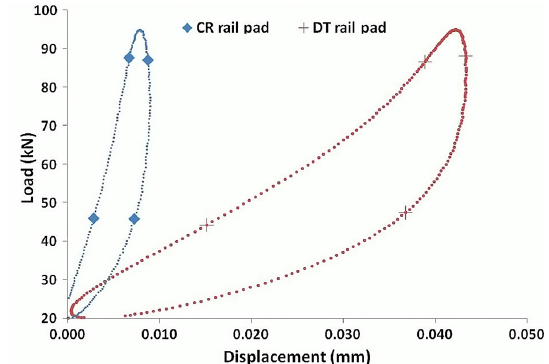
Fig. 5. Load-displacement curve of the dynamic test